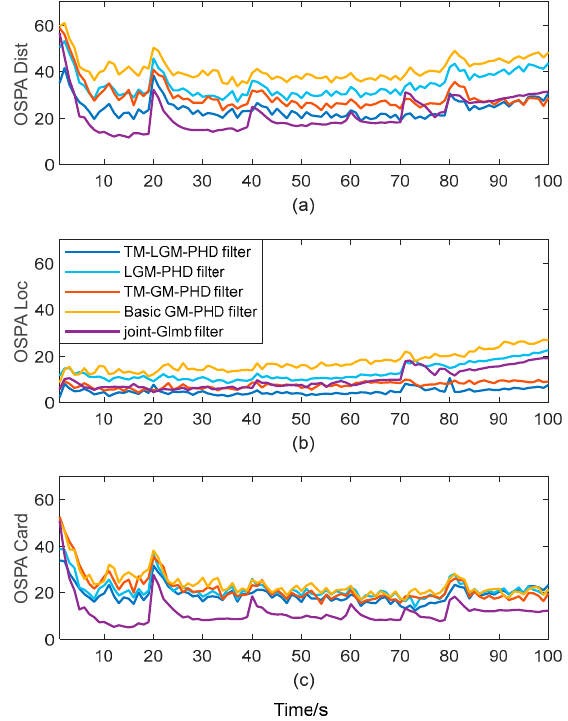
Figure 15. The average OSPA of different filters in example 2 (CA motion model) for 100 sample runs when T s = 1 s ( T i = 2 ms, λ = 104, p D , k = 0.8). ( a ) Average OSPA distances of different filters. ( b ) OSPA locations of different filters. ( c ) OSPA cardinalities of different filters.